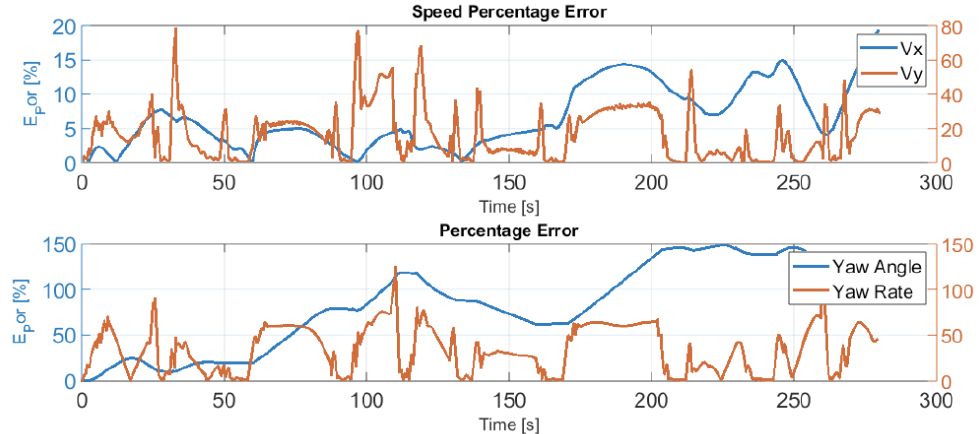
Figure 17. Dynamic speed profile results (error